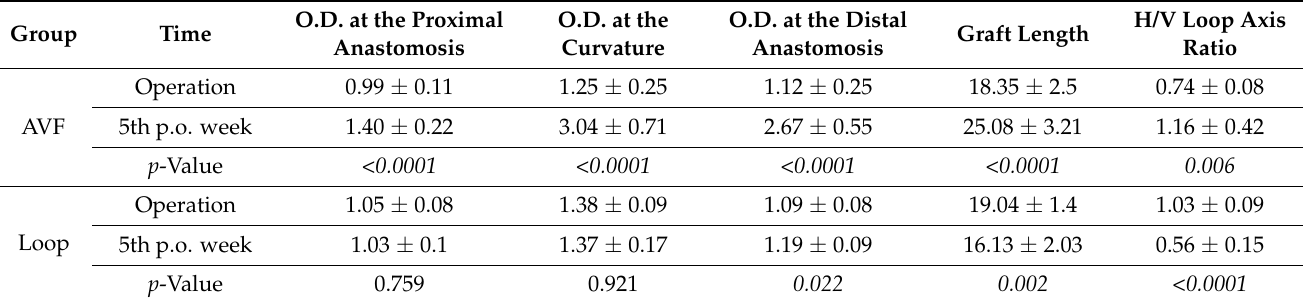
Table 1. Outer diameter (O.D.) values at various locations (mm), length (mm) and shape, as ratio (dimensionless) of vertical (V) and horizontal (H) axes of the loop-shaped fistulas or interpositioned grafts in the AVF and Loop groups just after the operation and in the fifth postoperative (p.o.) week.